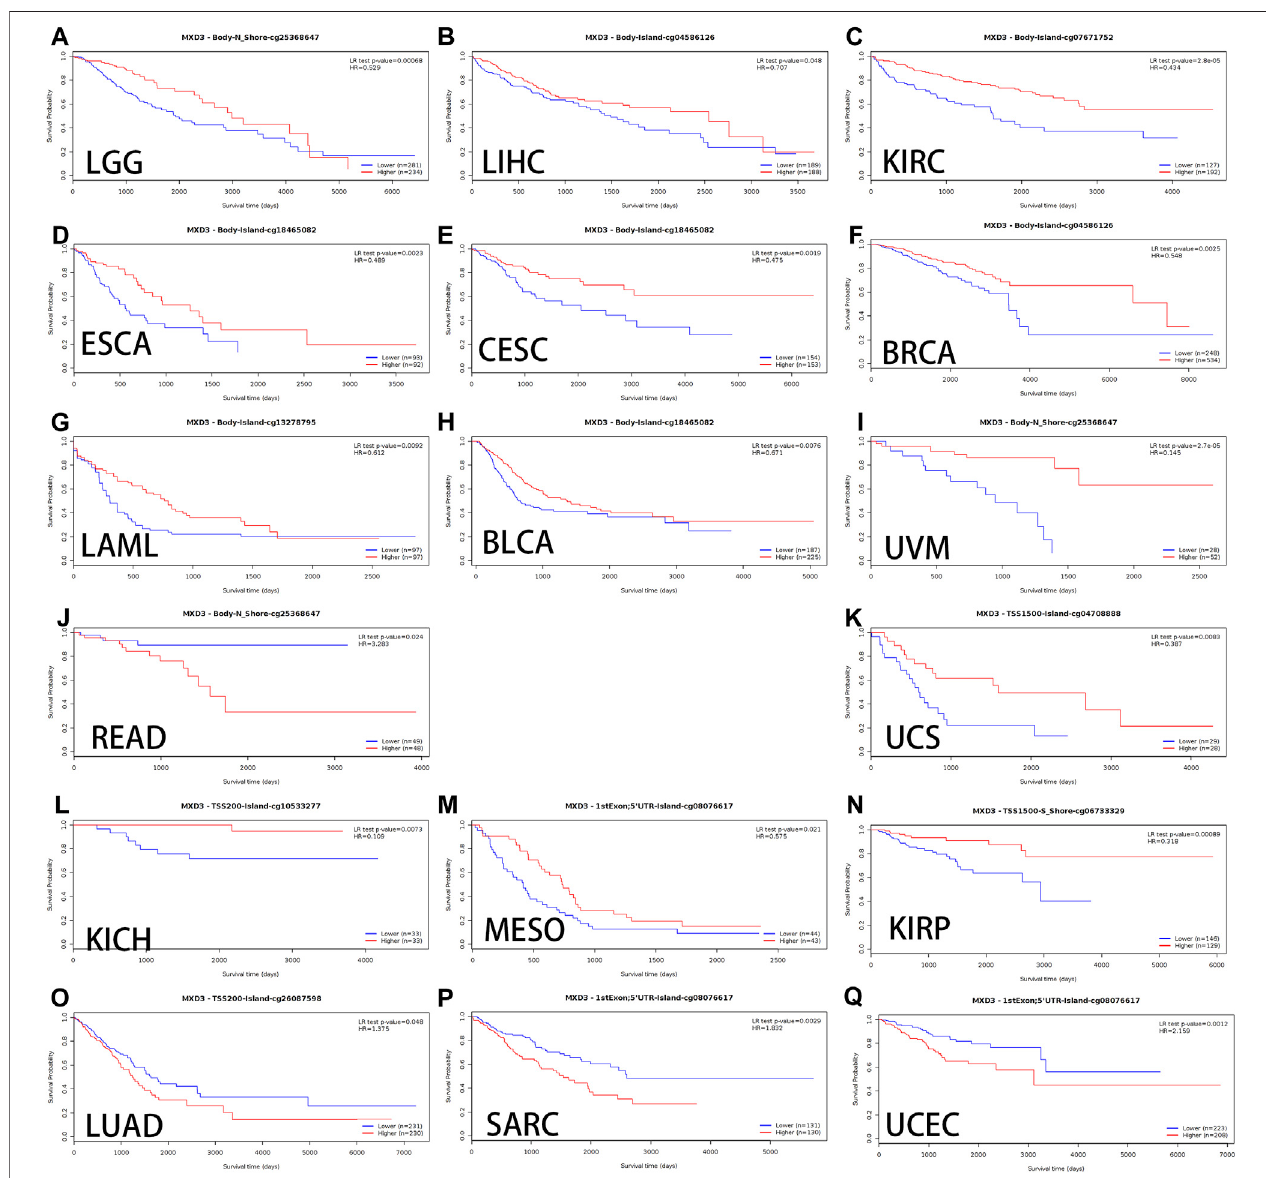
FIGURE7| OSofdifferentMXD3genebodiesinLGG (A) ,LIHC (B) ,KIRC (C) ,LAML (G) ,UVM (I) ,BLCA (H) ,CESC (E) ,ESCA (D) ,BRCA (F) ,andREAD (J) .OSof different promoter methylation statuses in KICH (L) , UCS (K) , KIRP (N) , MESO (M) , SARC (P) , LUAD (O) , and UCEC (Q) .